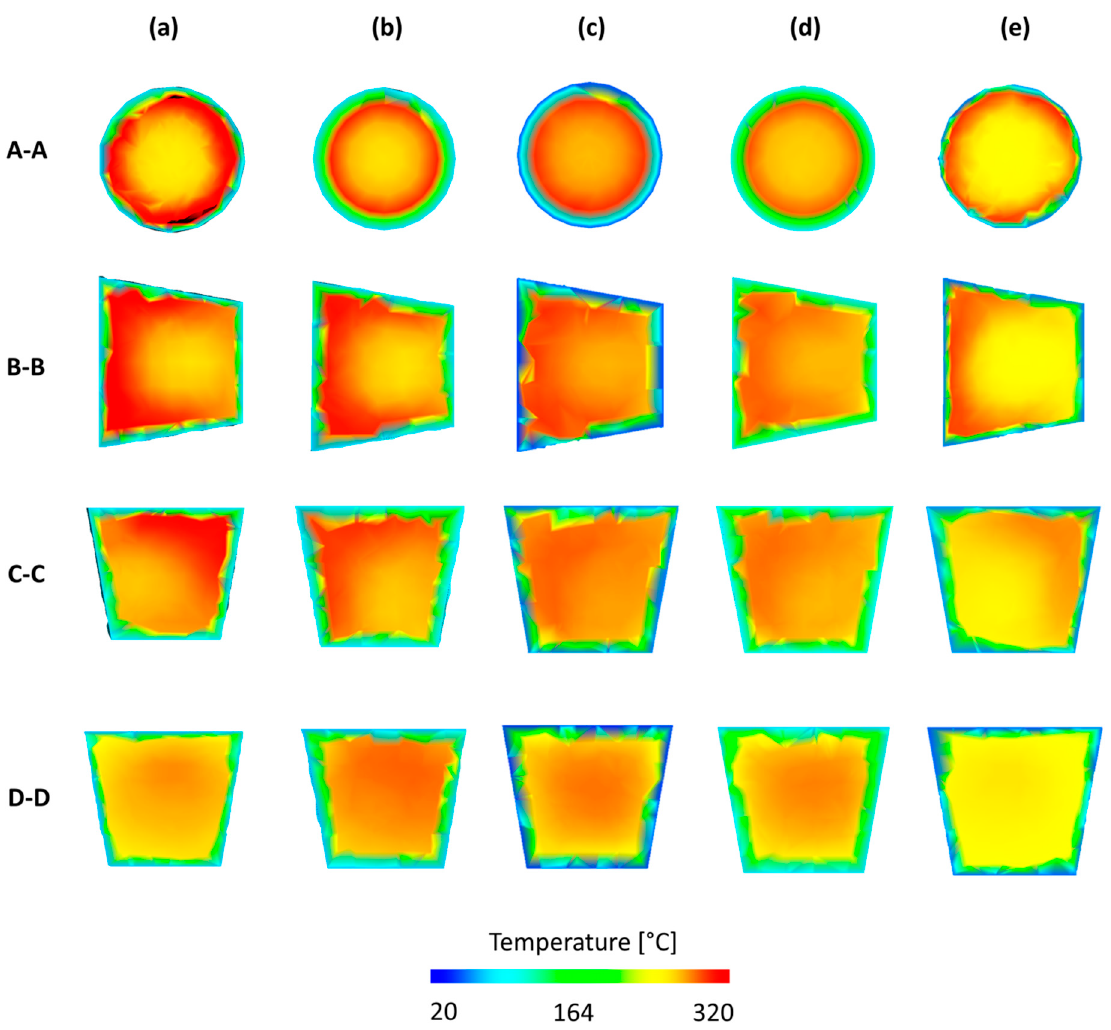
Figure 14. Temperature plots in specific cross-sections of the runner system obtained from simulations performed on different data, and using different optimization procedures: ( a ) maximum positive imbalance ( GS ), ( b ) maximum negative imbalance ( G2 ), ( c ) optimum RSM ( G2 ), ( d ) optimum Taguchi ( G2 ), ( e ) optimum STASA (G1) .